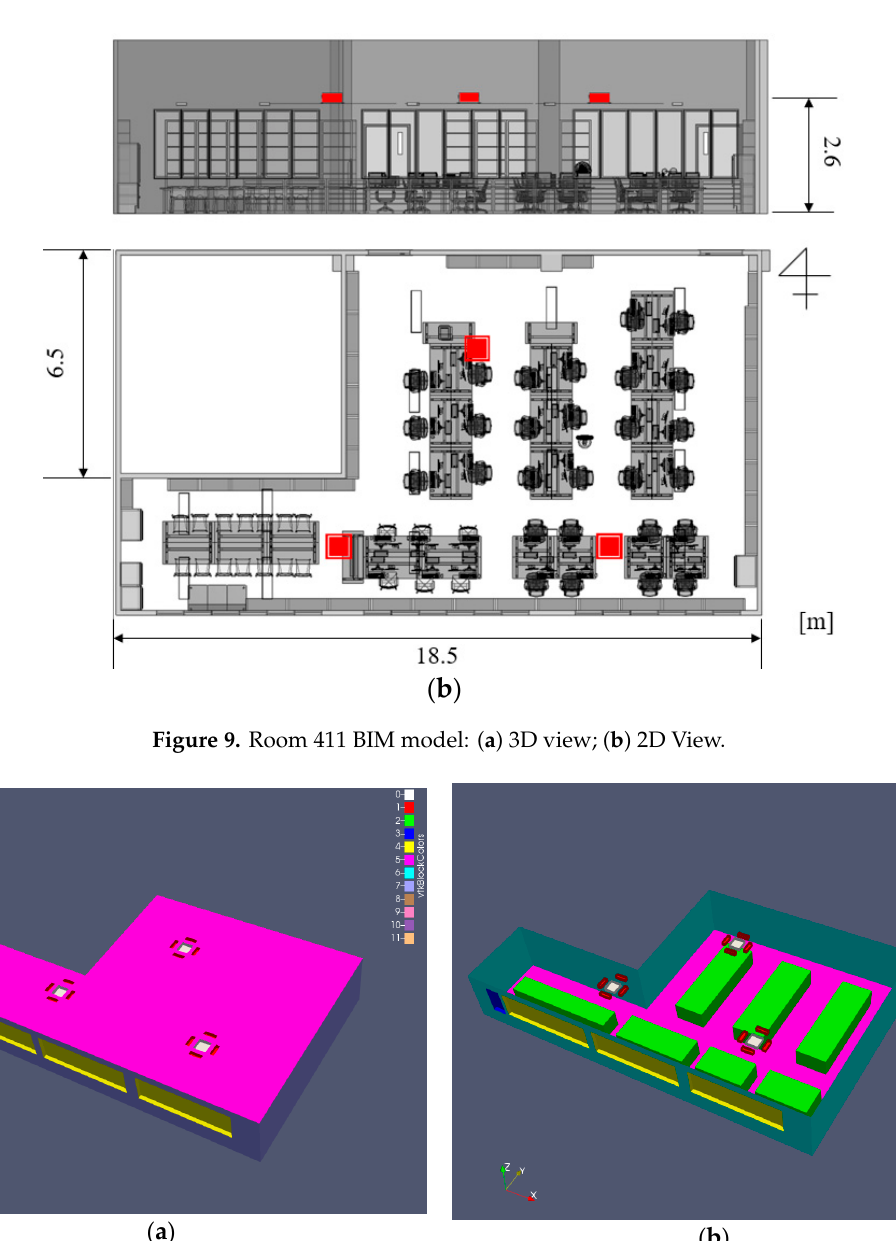
Table 2. Boundary conditions of the air conditioner.